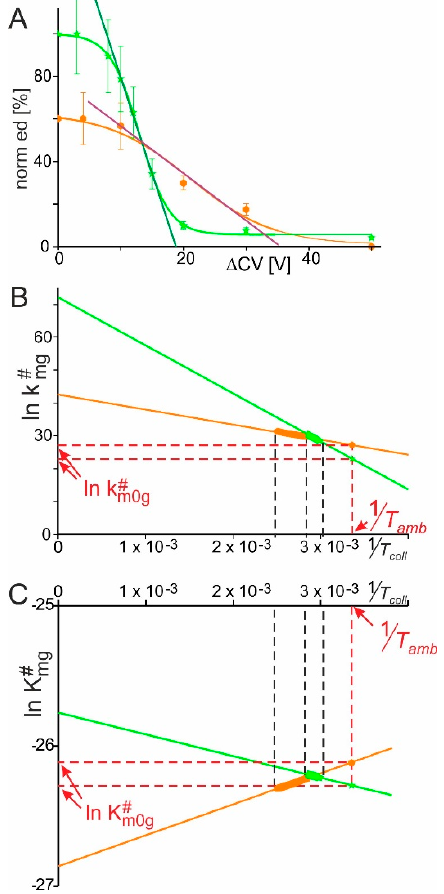
Figure 2. ( A ): Courses of normalized ion intensities of RNAse S ions ( nor m ( ed ) ) as functions of collision cell voltage differences ( ∆ CV ). Orange lines and data points: solution pH 4.5; green lines and data points: solution pH 7. Each data point is the mean of up to three independent measurements. Vertical bars give standard deviations. Curves were fitted using Boltzmann functions. Curve parameters used for calculations are listed in Table 1. Tangent lines are shown. ( B ): Arrhenius plots for the courses of RNAse S dissociation in the gas phase upon spraying at pH 4.5 or pH 7. Values for ln k # are taken from the points of the lines at 1 . Line color code as in A. ( C ): Plots for the courses of RNAse S dissociation reactions in the gas phase over temperature. Line color code as in A. Each data point (thickened parts of the lines) is obtained from Equation (4) and the values for ln K # D m0g are taken from the points of the lines at 1 . The thickened parts of the lines in B and C depict the data points from the experimentally accessible ranges (black dashed lines). Calculated kinetic and thermodynamic values are listed in Table 2. Table 2. Apparent kinetic and thermodynamic values for gas-phase dissociation of RNAse